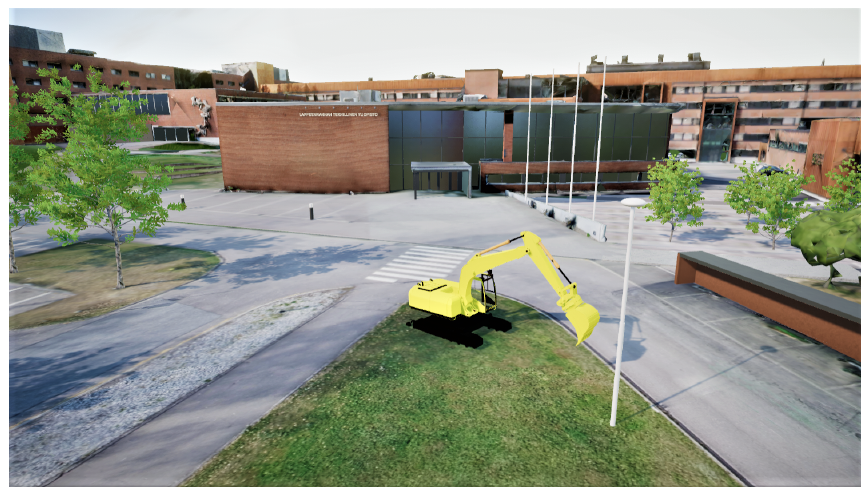
Figure 14. Excavator model in the LUT campus